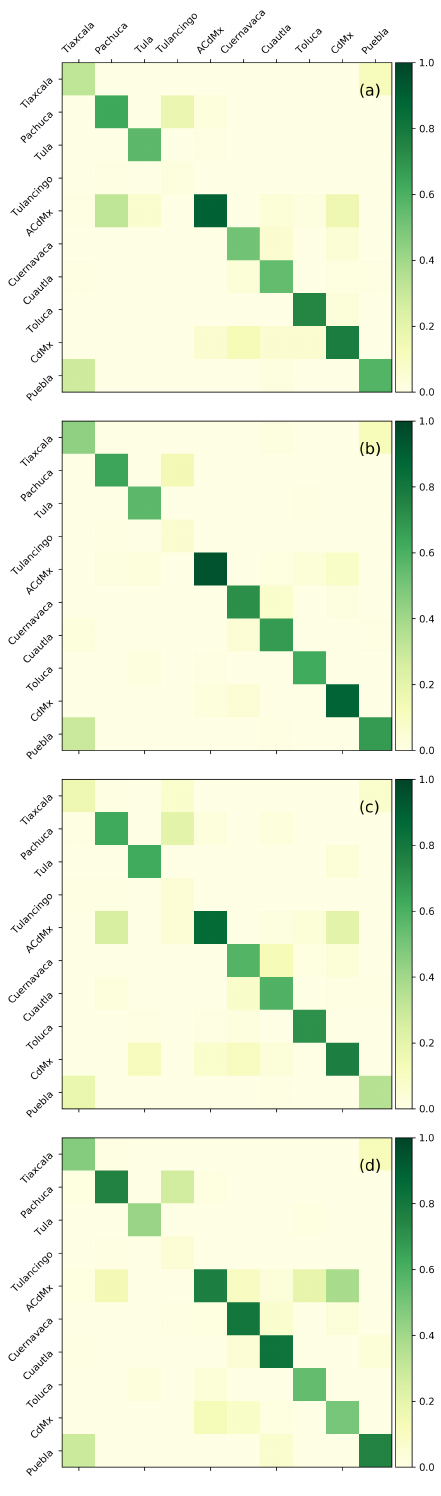
Figure 7. Averaging-kernel matrices showing the sensitivity and cross-sensitivities for the scaling of the different tracer fields. The same cases as in Fig. 4 are shown for the dates (a) 20 September, (b) 7 November, (c) 19 November 2018, and (d) 17 August 2019 but deploying the regularized